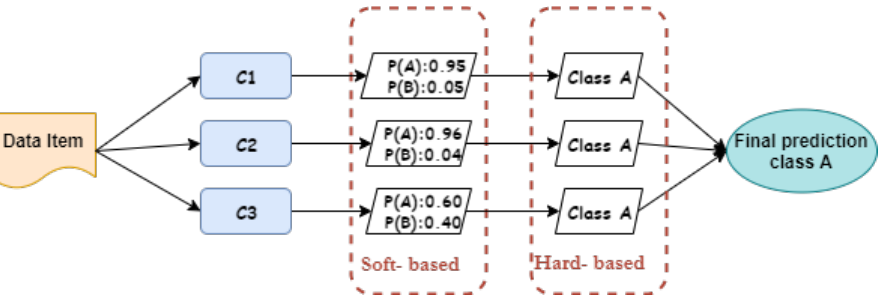
Figure 4. The proposed hybrid ensemble voting